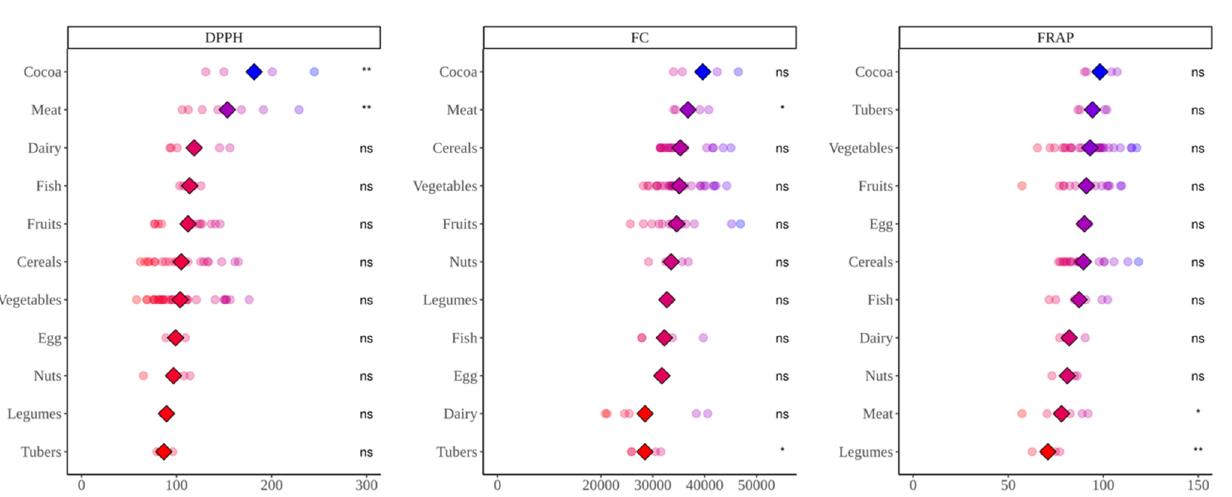
Figure 4. Antioxidant capacity of food obtained after in vitro fermentation of selected foods with fecal material from obese children. DPPH expressed as mmol Trolox equivalents/kg(L) of food; Folin–Ciocalteu (FC) expressed as mg equivalents of gallic acid/kg(L) of food; FRAP expressed as mmol Trolox equivalents/kg(L) of food. Diamonds represent the mean antioxidant capacity of each group. Dots represent the antioxidant capacity of each food within the group. Statistical analysis was performed via Kruskal–Wallis test. Each of the groups were compared to the average of all of them (i.e., base-mean). Statistic labels: *— p < 0.05, **— p < 0.01, ns—not significant.